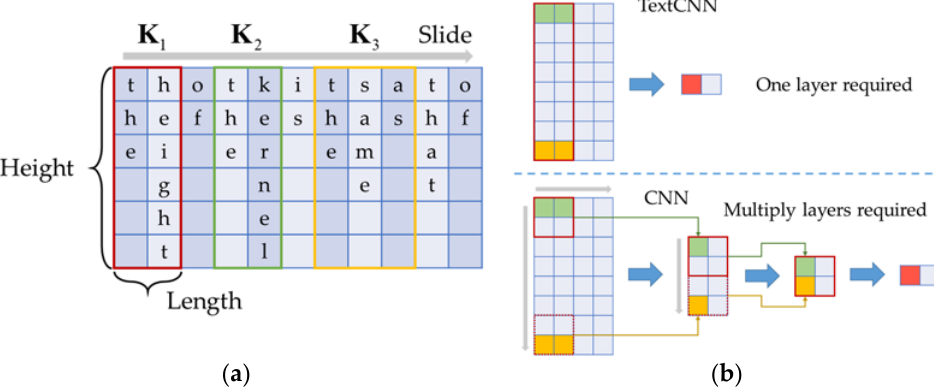
Figure 4. Characteristics of CNN: ( a ) feature schematic diagram of TextCNN’s kernels; ( b ) differences between CNN and TextCNN.